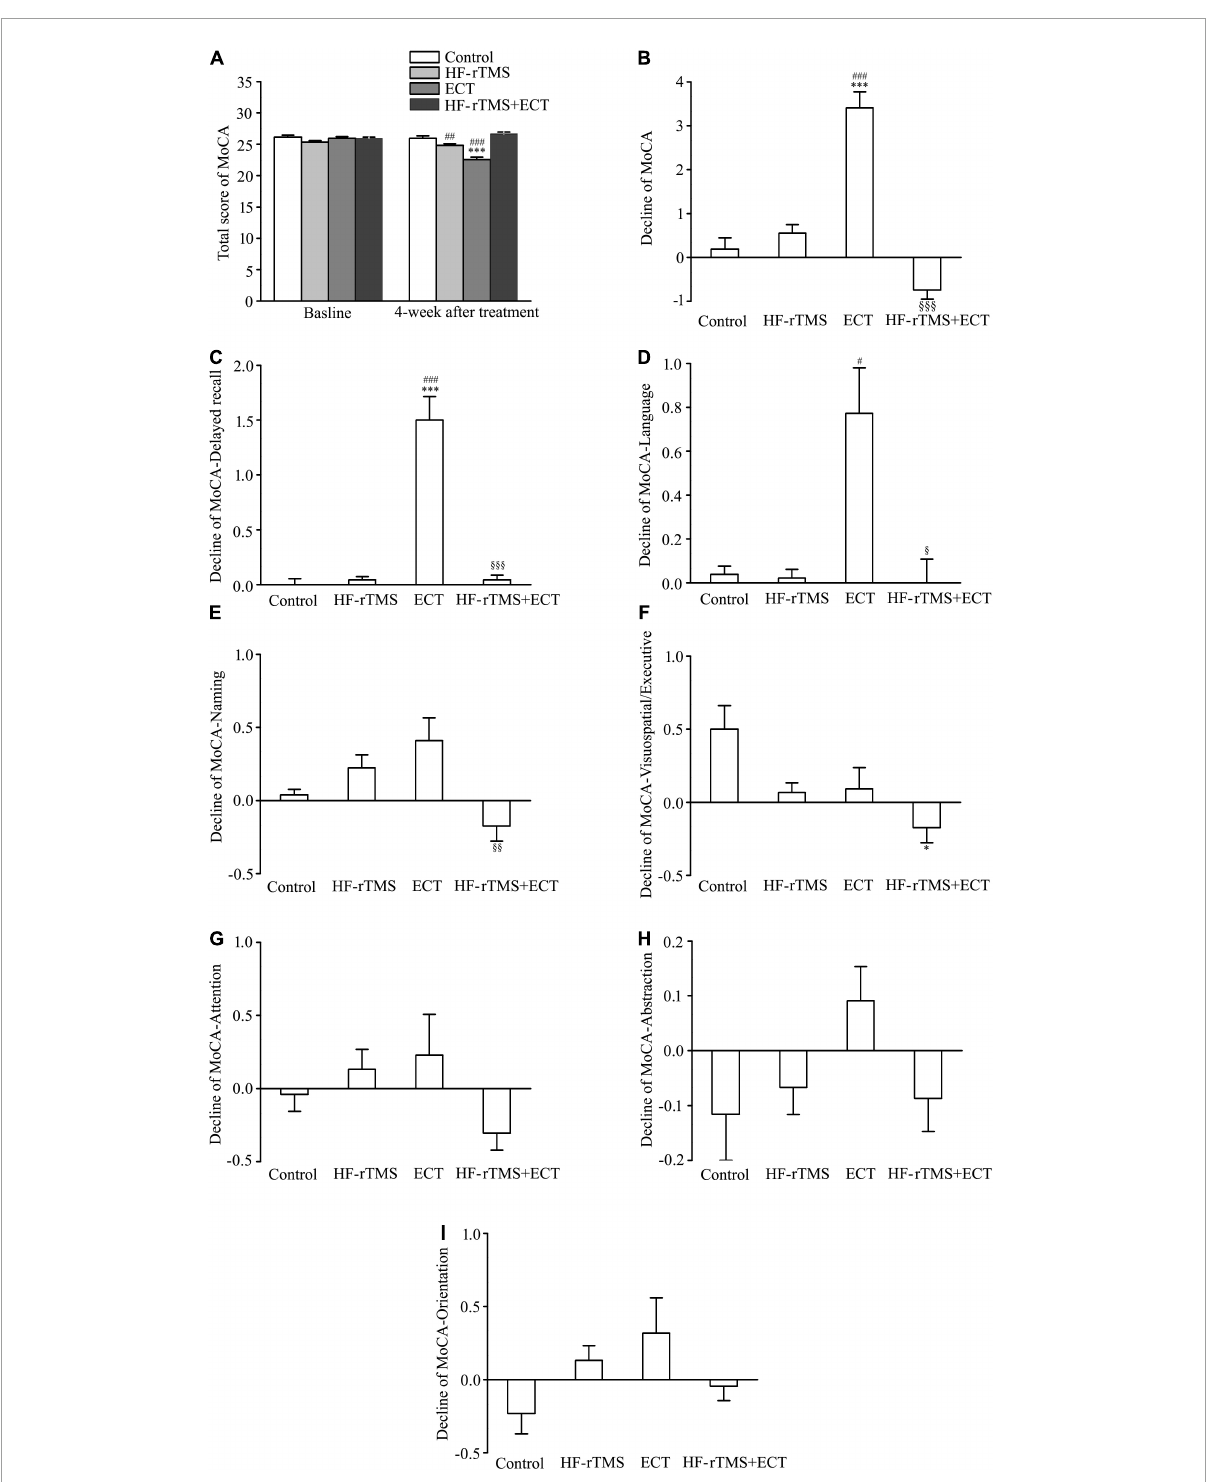
FIGURE4 High-frequency repetitive transcranial magnetic stimulation (HF-rTMS) reversed the cognitive impairment evoked by ECT. (A) Total scores of MoCA at baseline and 4 weeks after treatment. ∗∗∗ p < 0.001, compared with baseline levels; ## p < 0.01, ### p < 0.001, compared with control at 4-week after treatment. (B) Decline in total scores of MoCA from baseline to post-intervention at 4 weeks. ∗∗∗ p < 0.001, compared with control; ### p < 0.001, compared with HF-rTMS. §§§ p < 0.001, compared with ECT. (C–I) Decline in scores of five performances in MoCA; delayed recall (C) , language (D) , naming (E) , visuospatial/executive (F) , attention (G) , abstraction (H) , and orientation (I) . ∗ p < 0.05, ∗∗∗ p < 0.001, compared with control; # p < 0.05, ## p < 0.01, ### p < 0.001, compared with HF-rTMS; § p < 0.05, §§ p < 0.01, §§§ p < 0.001, compared with ECT (C–F) . Graphs show mean ±